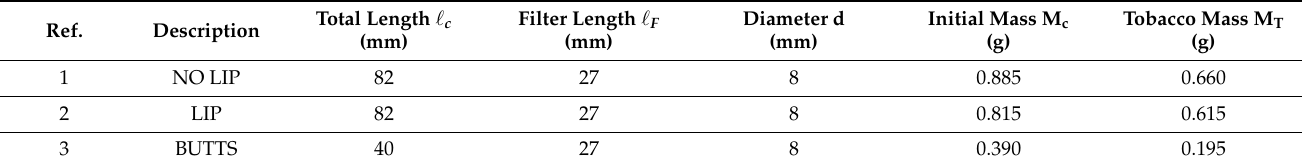
Table 2. Properties of the cigarettes used in the rate of combustion and fuel bed ignition tests. Ref.